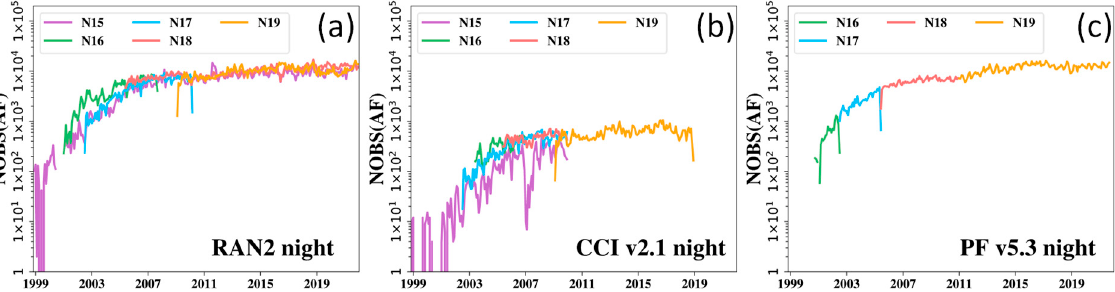
Figure 13. Monthly numbers of validation matchups with AFs for ( a ) RAN2, ( b ) CCI and ( c ) PF L3C SSTs, for AVHRR/3 radiometers. (Data are from the NOAA SQUAM system [21,22]).